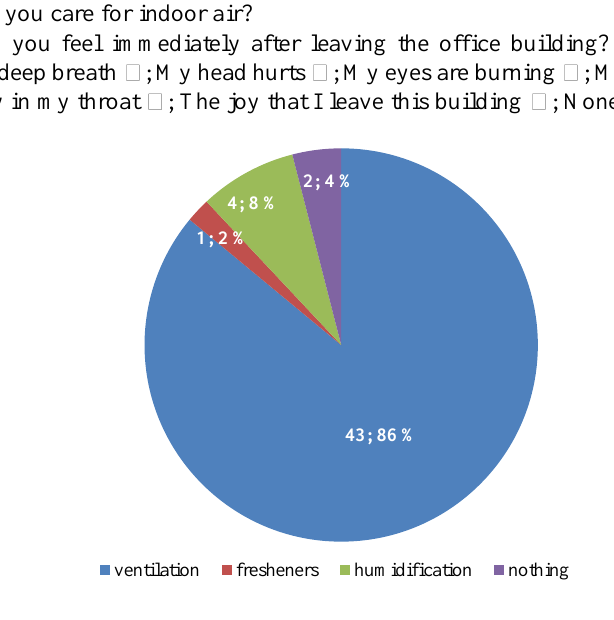
Fig. 6. Answers to the question: How do you care for air in the rooms?